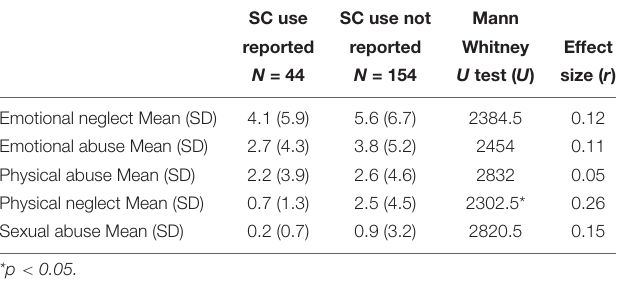
TABLE 3 | Childhood traumatic experiences among OST clients with and without a history of past year SC use.